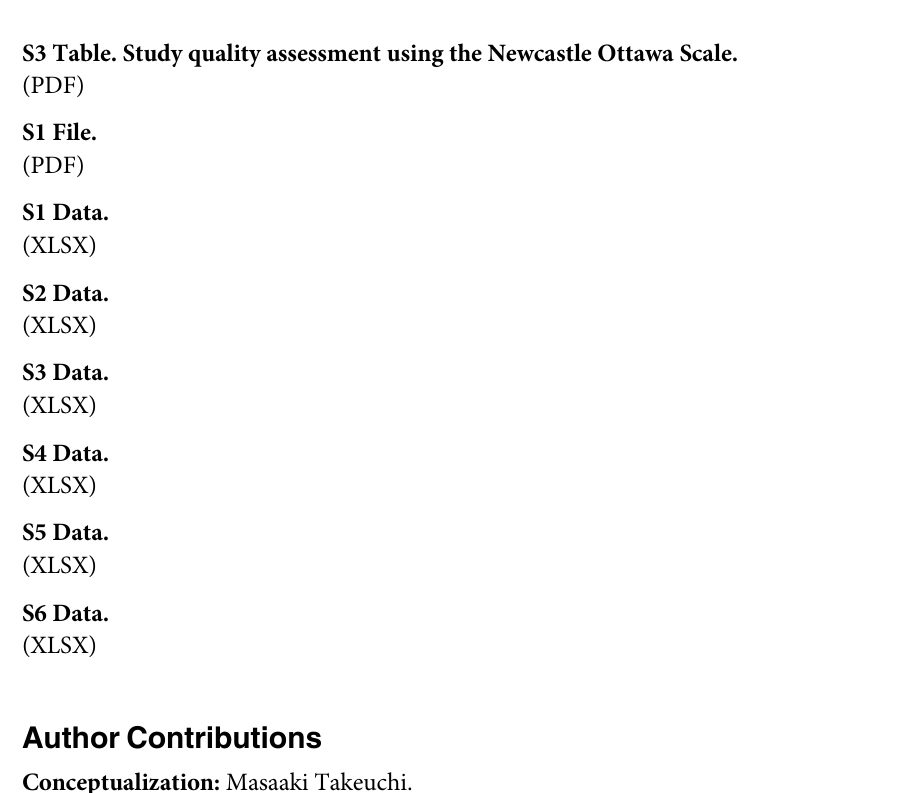
S3 Table. Study quality assessment using the Newcastle Ottawa